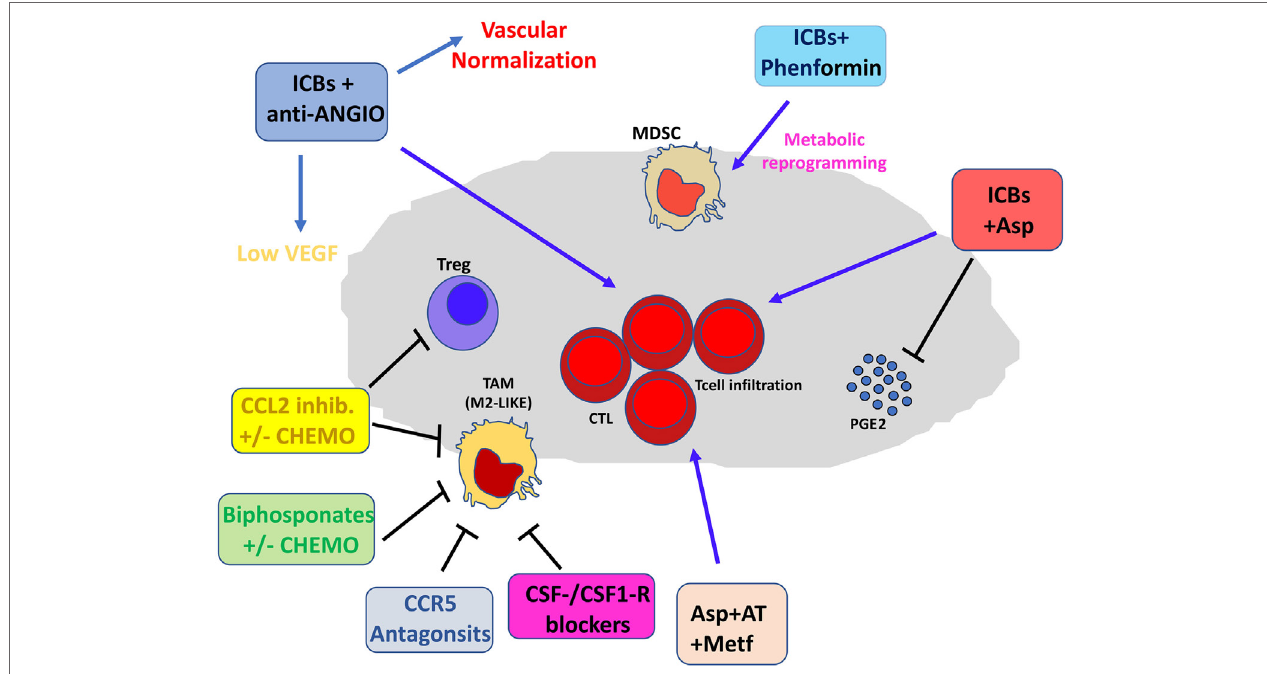
FigURe 3 | Pharmacological and immunotherapeutic combination targeting the tumor microenvironment (TME). Immune checkpoint blockers (ICBs) can be employed in diverse pharmacological combinations resulting in clinical benefit for patients. ICBs + antiangiogenic agents result both in inhibition of aberrant angiogenesis and vascular normalization with subsequent efficient T cell infiltration. CCL2 inhibitors combined with chemotherapy dampen induction of M2-like tumor-associated macrophages (TAMs) in the TME and T regulatory (Treg) proliferation. Bisphosphonates + chemotherapy target M2-like TAMs. Anti-Angio, VEGF inhibition and eventually angiopoietin-2 blockade; Asp, aspirin; AT, atenolol; Metf, metformin; Chemo, standard chemotherapeutic